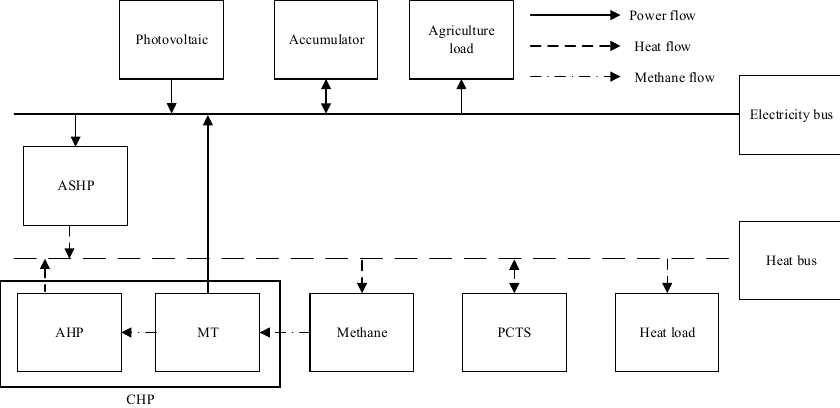
Figure 1. The basic on-line diagram of greenhouse micro grid.